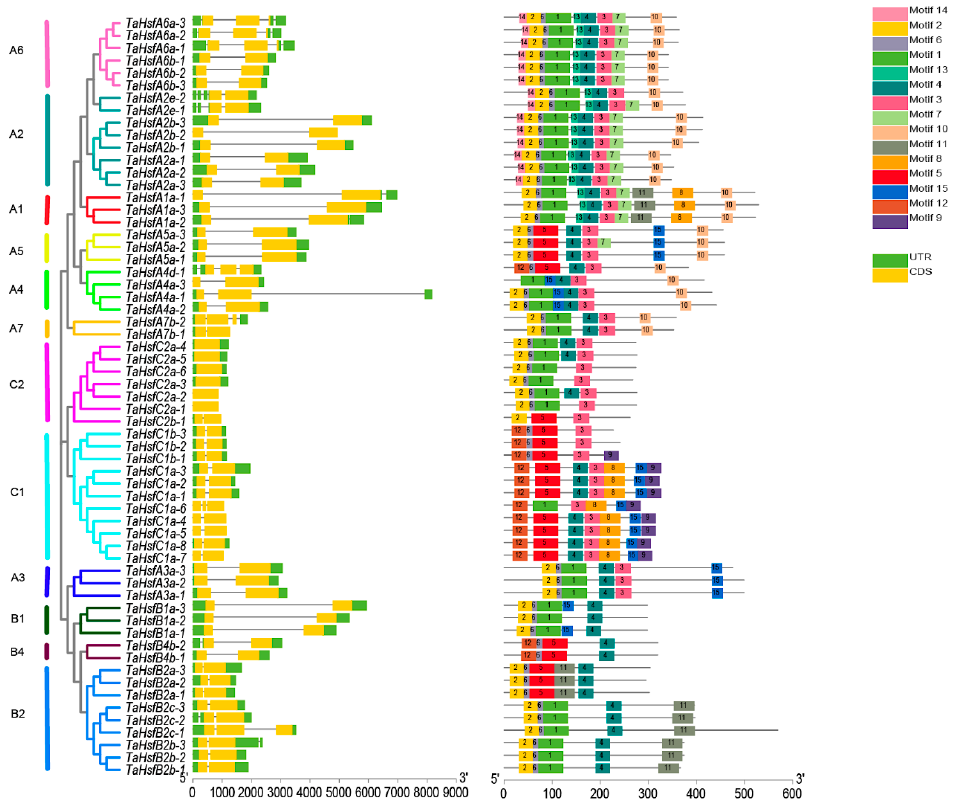
Figure 5. Phylogenetic tree, gene structure, and architecture of conserved protein motifs in TaHsfs. Details of the clusters in the phylogenetic tree are shown in different colors. The left panel represents the intron–exon structure of the TaHsfs , and the right panel shows the motif compositions of the TaHsfs . Different motifs are indicated by different colors and they are numbered from 1–15.